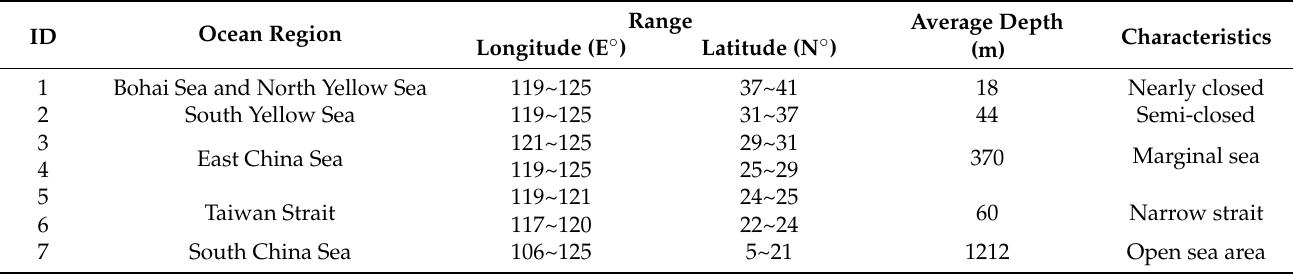
Table 1. Longitude and latitude range and characteristics of study